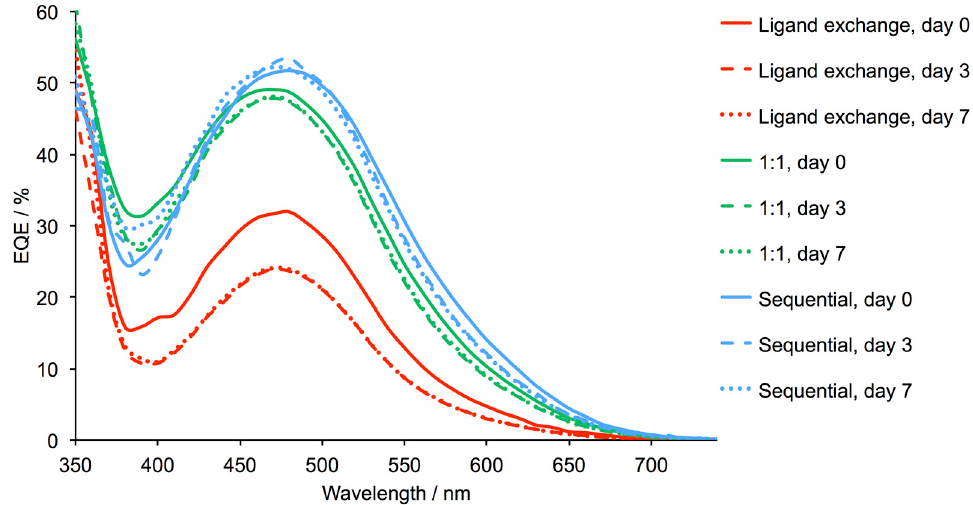
Figure 10. EQE spectra for DSSCs (cell 2 in each case, see Table 3) with photoanodes assembled using the three assembly protocols described in the Materials and Methods section.